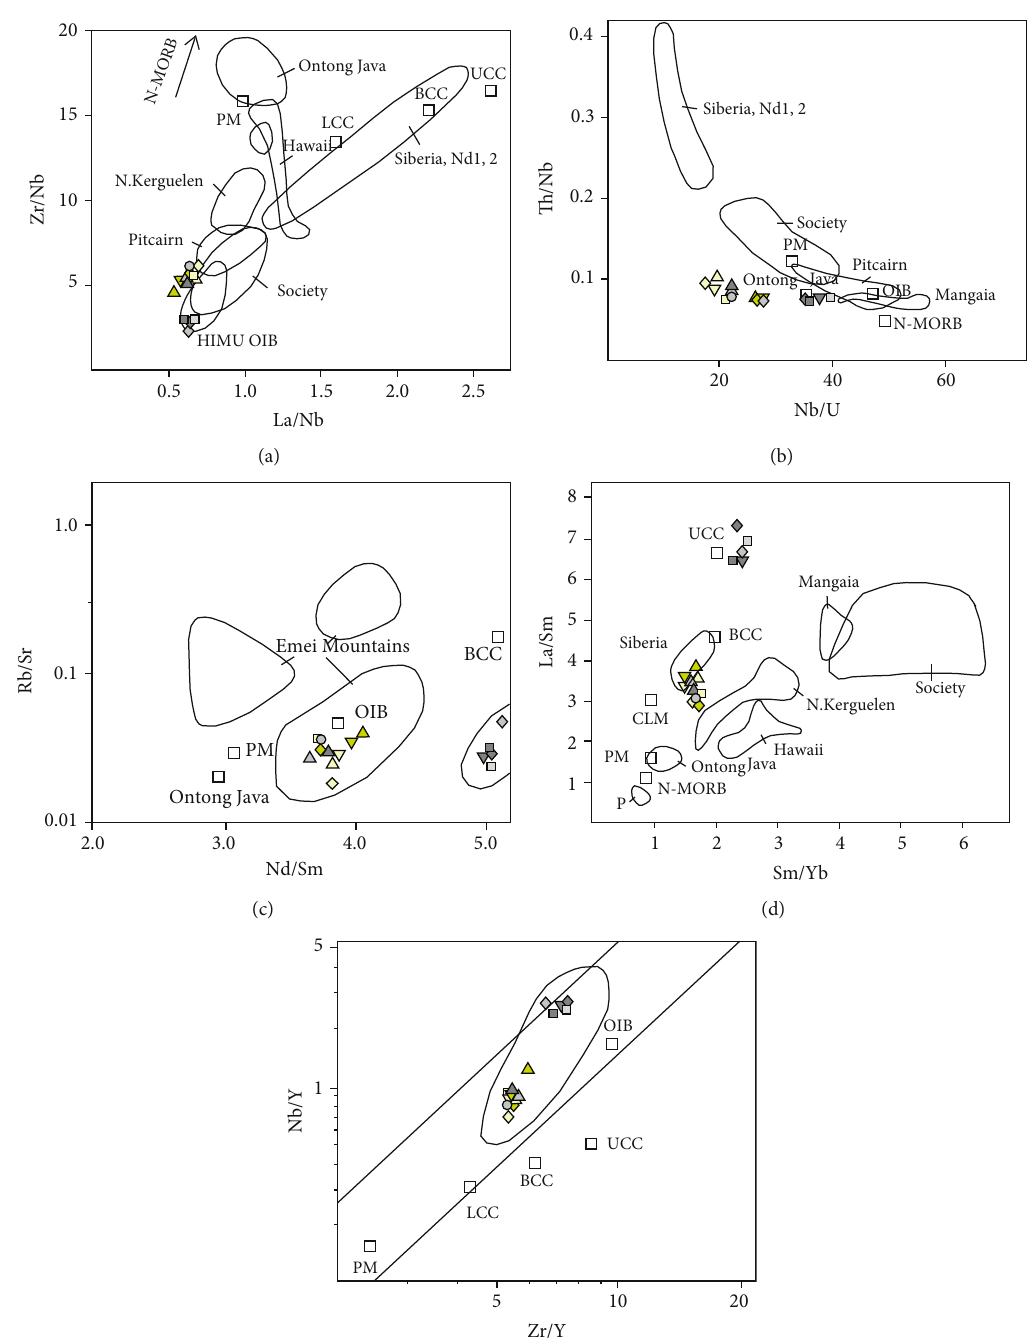
Figure 9: Trace element ratios of Paleogene igneous rocks in Huimin Sag. (a) Zr/Nb vs. La/Nb, (b) Th/Nb vs. Nb/U, (c) Rb/Sr vs. Nd/Sm, (d) La/Sm vs. Sm/Yb, and (e) Nb/Y vs. Zr/Y diagrams for the Paleogene igneous rocks from the Huimin Sag. Data sources are as follows: PM refers to primitive mantle values [63]; UCC, BCC, and CC mark the upper continental crust, whole continental crust, and average compositions of bulk, respectively [64]. HIMU OIB [65]; Pitcairn [66]; Society [43]; Ontong Java [67]; N. Kerguelen [68]; Hawaii [69]. Siberia, Nd1, 2 represent crustal contamination lavas typically [70]. The arrow points to the average MORB values: Zr/Nb = 31 : 76 , La/Nb = 1 : 07 [57]. The values for OIB are from Sun and McDonough [57]. Composition of continental lithospheric mantle (CLM) is from McDonough [71]. Parallel lines mark the upper and lower bounds of the Iceland basalt data [72], All the symbols are the same as in Figure exhibited 87 Sr/ 86 Sr of 0.7046 to 0.7098 (average of 0.7075) Third is the moderate 143 Nd/ 144 Nd region, represented by samples Xia 381-1-a, Xia 38-3, Xia 39-1, Shang 745-6, Xia 38- and 143 Nd/ 144 Nd of 0.5126 to 0.5127 (average of 0.5126). 2, Shang 745-4, Shang 745-E, and Xia 382-5. These samples The samples plot within the area close to the OIB and the